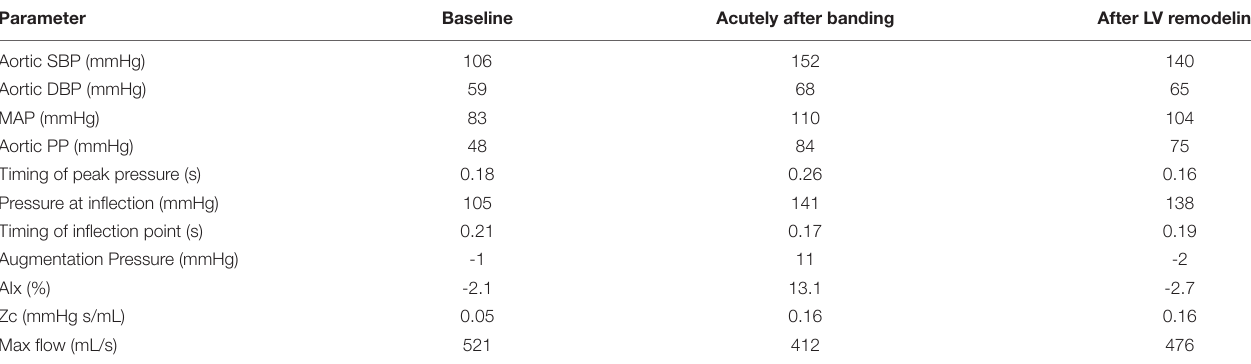
TABLE 2 | Hemodynamic characteristics at baseline, acutely after banding, and after LV remodeling. Parameter Baseline Acutely after banding After LV remodeling